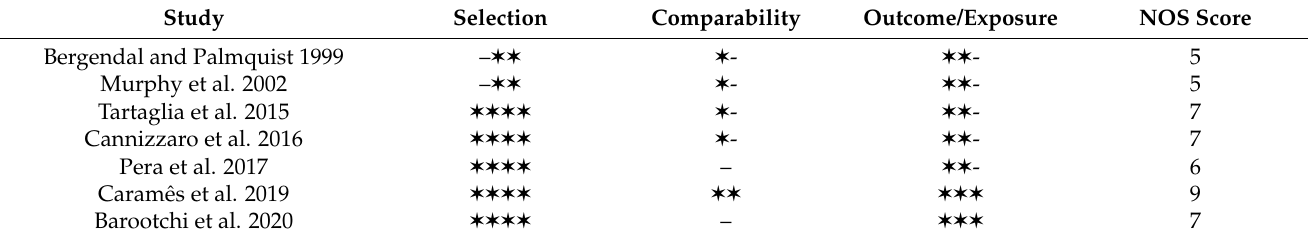
Table 3. Risk of bias for the cohort studies included in the present systematic review according to the NOS-Newcastle– Ottawa Scale. A star system was used in order to perform a semi quantitative assessment of study quality. A study was awarded a maximum of one star ("*") for each numbered item satisfied in Selection, Comparability and Exposure/outcome categories. The symbol "-" means that the item was not